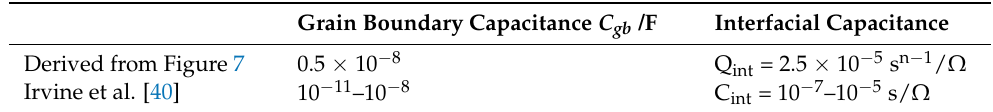
Table 3. Key parameters derived from the equivalent circuit shown in Figure 7 and capacitance values corresponding to grain boundaries and interfaces given by Irvine et al. Grain Boundary Capacitance C gb /F Interfacial Capacitance Derived from Figure